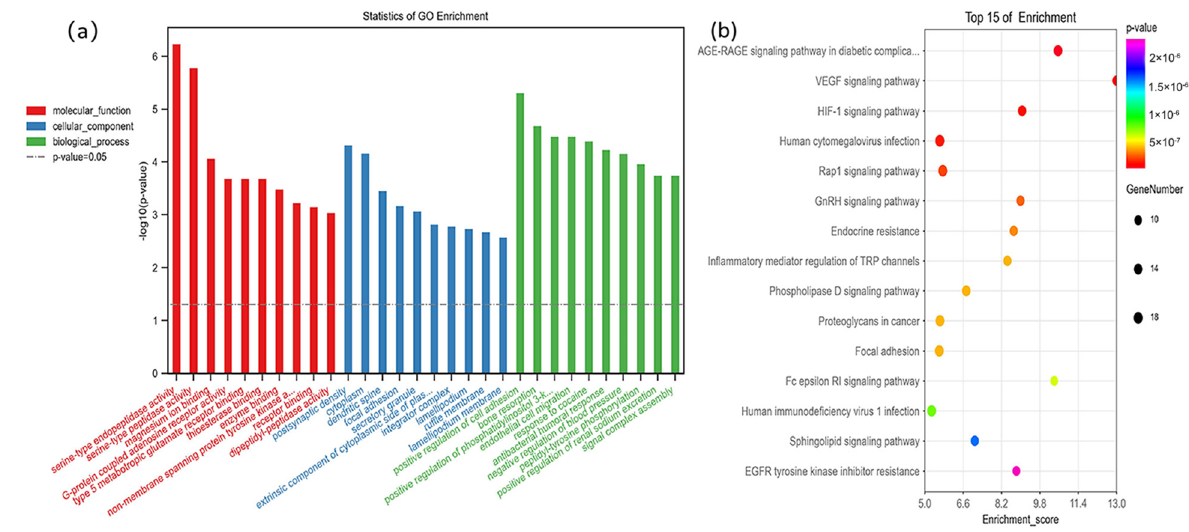
Figure 4. The top 10 gene ontology ( a ) and top 15 KEGG pathways ( b ) enrichment analysis of fluoride-related genes using oebiotech, and the fluoride-related genes are obtained from Gene Cards (https://www.genecards.org/; accessed on 18 April 2022) with a score greater than 1.5.